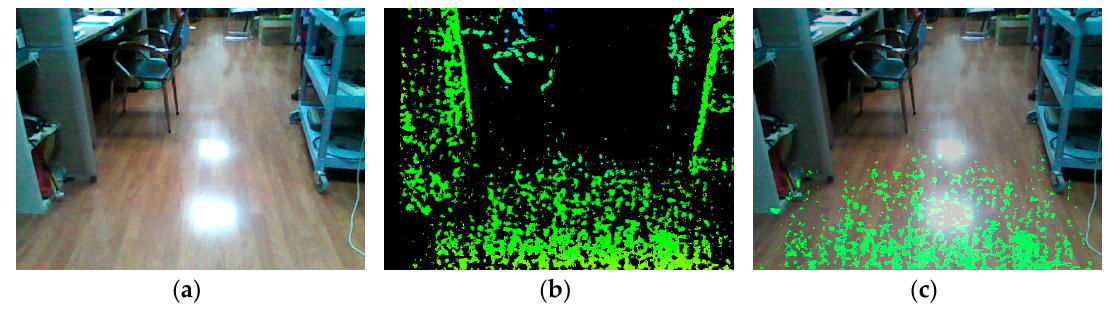
Figure 2. ( a ) Color image captured by the RealSense R200; ( b ) the original depth image captured by the RealSense R200; ( c ) traversable area detection with original depth image of the RealSense R200, which is limited to short range.